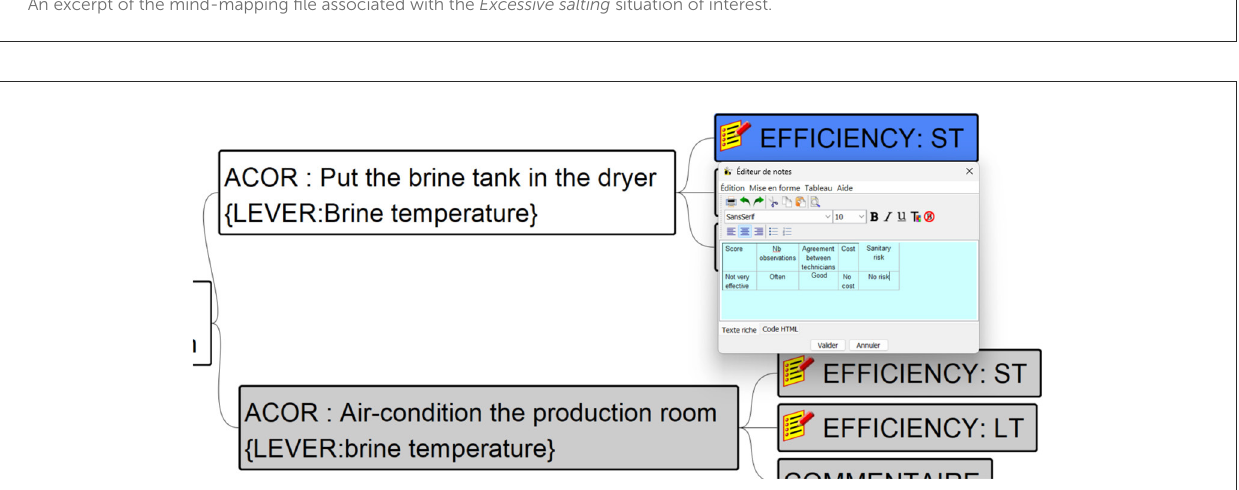
FIGURE4 Zoom on the table associated with the EFFICIENCY: ST node present in the mind-mapping file associated with the Put the brine tank in the dryer